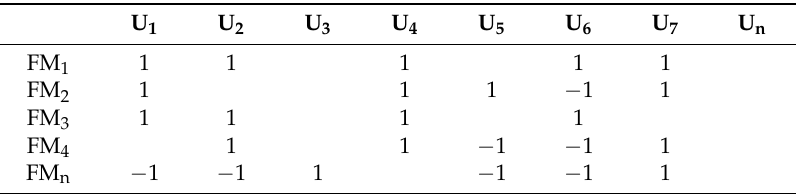
Table 2. Menu rating